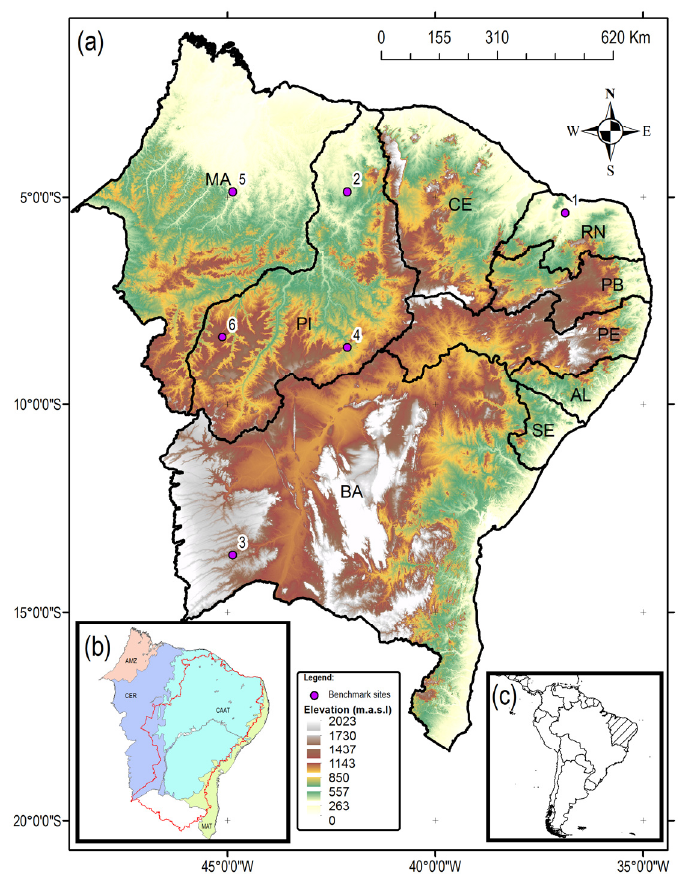
Figure 1. ( a ) Northeast Brazil’s terrain elevation. Elevation based on 90-m DEM-SRTM images [58] Circles denote the location of benchmark sites. ( b ) NEB’s main biomes: AMZ, Amazônia; CER, Cerrado; MAT, Mata Atlântica; and CAAT, Caatinga. The red line depicts the border of the Sertão region. ( c ) NEB’s location in South America. The scale bar refers to the center of the map.